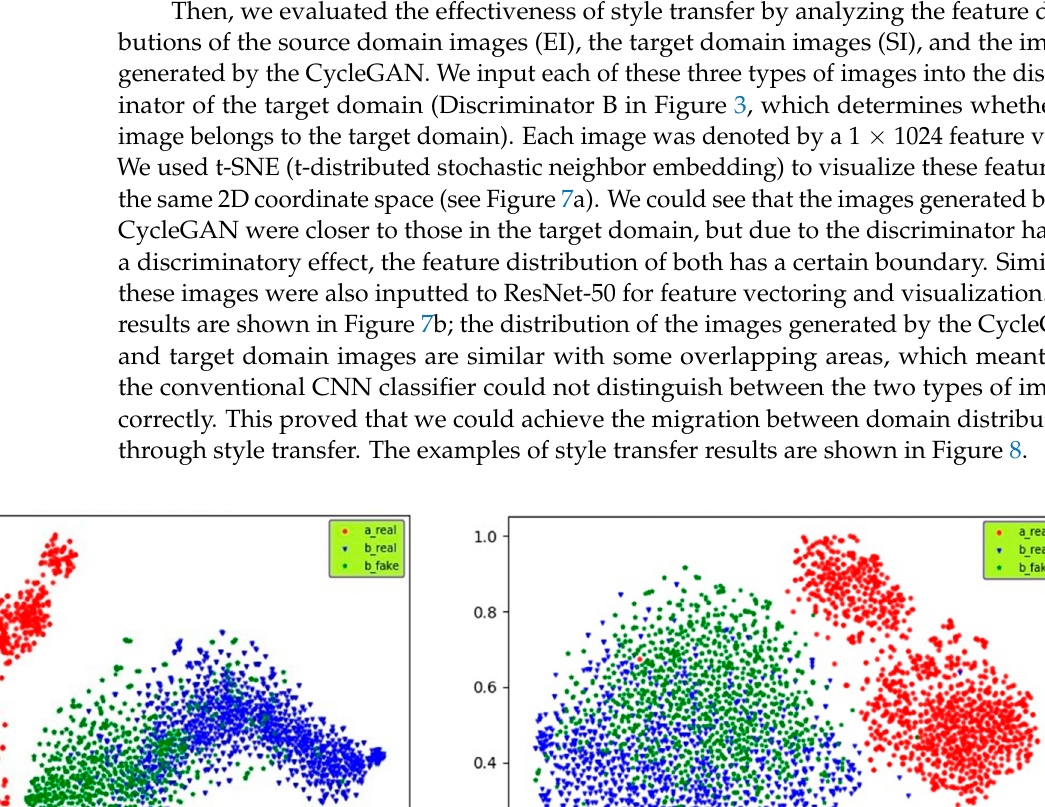
Figure 6. Examples of model depth map prediction results. The first row shows virtual endoscopic images (SI), the second row shows the predicted depth map, and the last row displays the ground truth of the depth map.